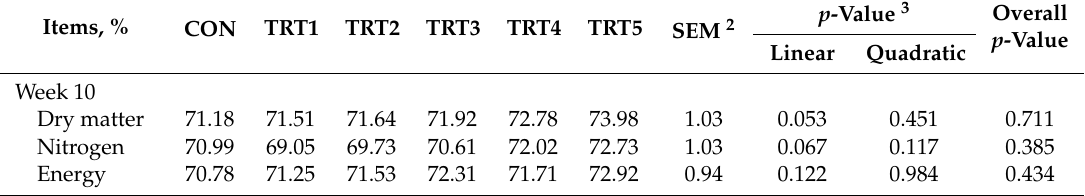
Table 3. The e ff ect of black pepper supplementation on the nutrient digestibility of finishing pigs 1